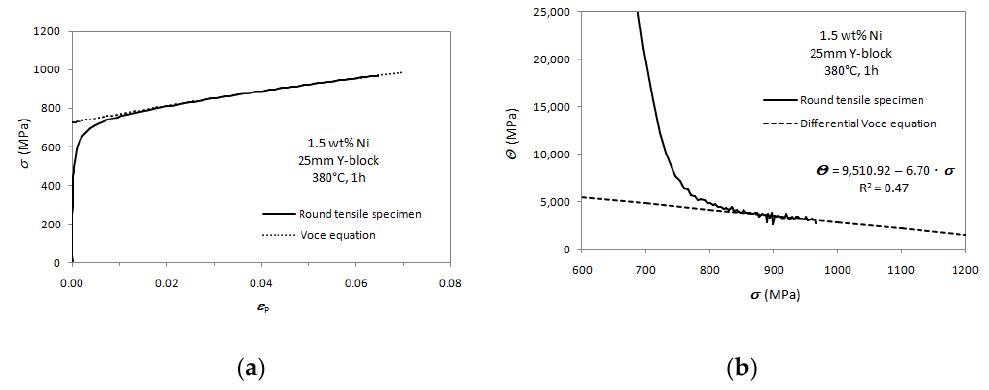
Figure 3. Tensile plastic behavior fitting with Voce equation: ( a ) tensile flow curve with round tensile specimen of 1.5 wt% Ni ADI from 25 mm Y-block austempered at 380 °C for 1 h; ( b ) differential data from the flow curve in a) and strain hardening analysis based on Voce equation with best linear fit: intercept Θ o = 9510.92 MPa; slope 1/ ε c =